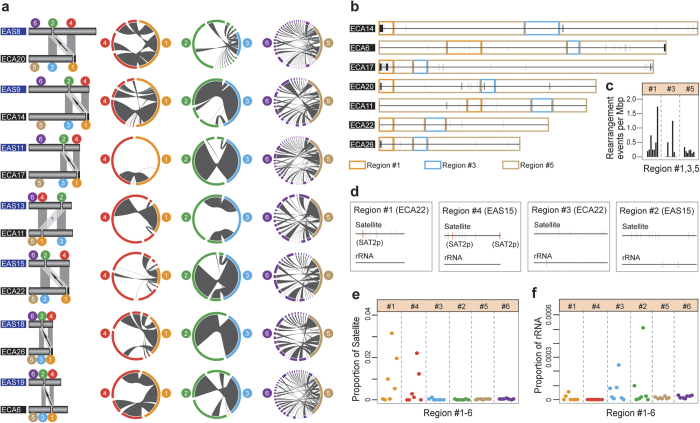
Chromosomal rearrangements and characteristic sequences in centromere regions.(a) Landscape of chromosomal rearrangements. Column 1: Six regions categorized in donkey and horse chromosomes. They are: #1(orange): Centromere regions in the horse chromosome; #2(green): Centromere regions in the donkey chromosome (at least 6 centromeres are neocentromeres); #3(blue): Homologous regions in the horse chromosome related to region #2; #4(red): Homologous regions in the donkey chromosome related to region #1; #5(brown): Other regions in the horse chromosome; #6(purple): Other regions in the donkey chromosome. (EAS: Equus asinus; ECA:Equus caballus). The arrow indicates the direction of two corresponding centromere repositionings. The question mark (‘?’) indicates the direction of two corresponding centromere repositionings that are not classified. Column 2: Synteny analysis between region #4 and region #1. Column 3: Synteny analysis between region #2 and region #3. Column 4: Synteny analysis between region #6 and region #5. (b) Chromosomal rearrangements between donkey and Thoroughbred horse. Black vertical lines represent rearrangement regions in the Thoroughbred horse chromosomes. (c) Numbers of rearrangements events in seven pairs of chromosomes. (d) Distribution of satellite sequences and ribosomal RNA in region #1, #3 of ECA22 and region #2, #4 of EAS15. (e) Proportion of satellite sequences in regions #1–6. (f) Proportion of ribosomal RNA in regions #1–6.